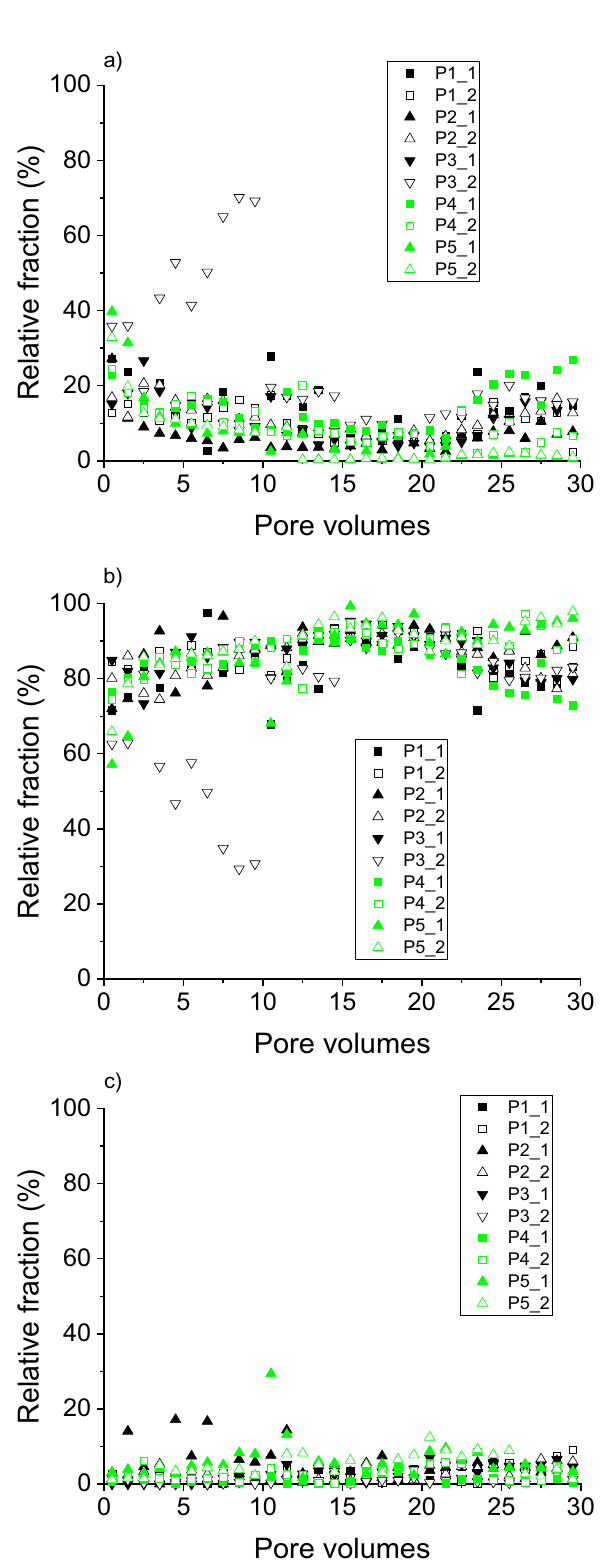
Figure 6. Relative distribution of dissolved organic carbon eluted from soils with increasing degrees of podzolisation (P1 to P5) in irrigation experiments between fractions. ( a ) < 1 kDa, ( b ) 1 kDa–0.45 µm, ( c ) > 0.45 µm. ‘_1’ and ‘_2’ denote duplicate